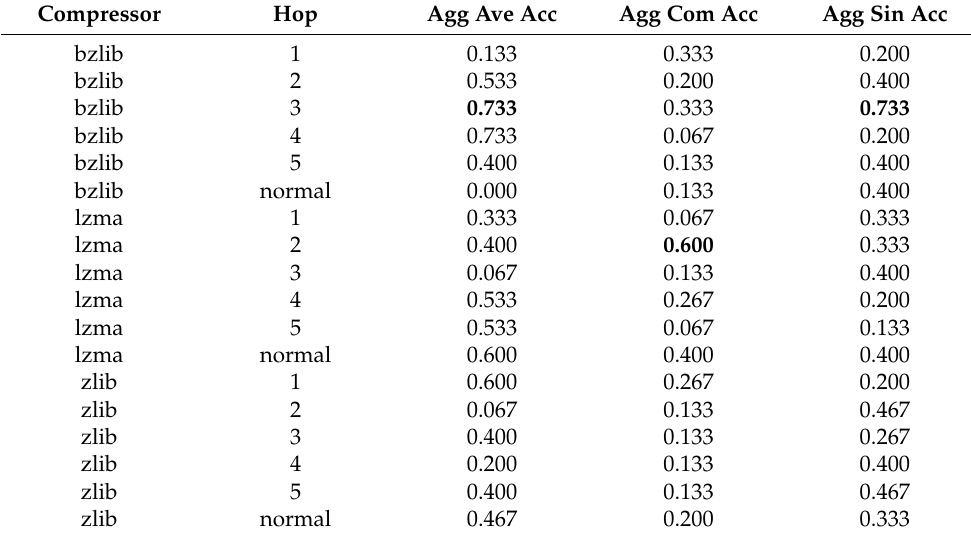
Table 6. Accuracy scores of Agglomerative clustering models generated using NCD distance